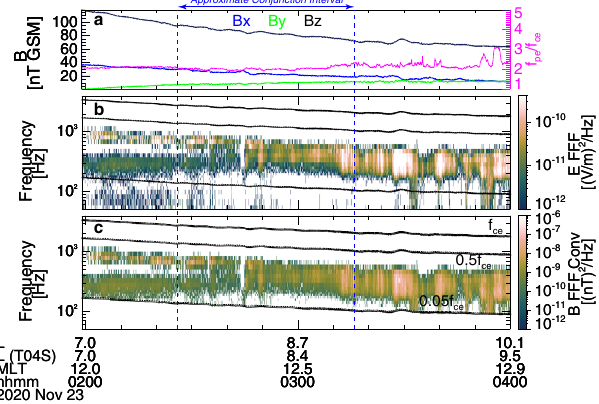
Fig. 3 Overview of THEMIS-E spacecraft observations from 02:00 to 04:00 UT on 23 November 2020 (the interval of approximate conjunction with ELFIN-A spacecraft is delimited by two vertical dashed blue lines). a Magnetic fi eld vector (left axis): B x (blue), B y (green), and B z (black) components in the geocentric solar magnetospheric (GSM) coordinate system, and plasma frequency to gyrofrequency ratio (magenta) f f fi eld spectra and c pe / ce (right axis), whistler-mode wave b electric magnetic fi eld spectra converted from electric spectra. THEMIS-E L location from dipole and TS04 magnetic fi eld models ( L is the equatorial geocentric distance of the magnetic fi eld line, in Earth radii) and magnetic local time (MLT) are shown in the